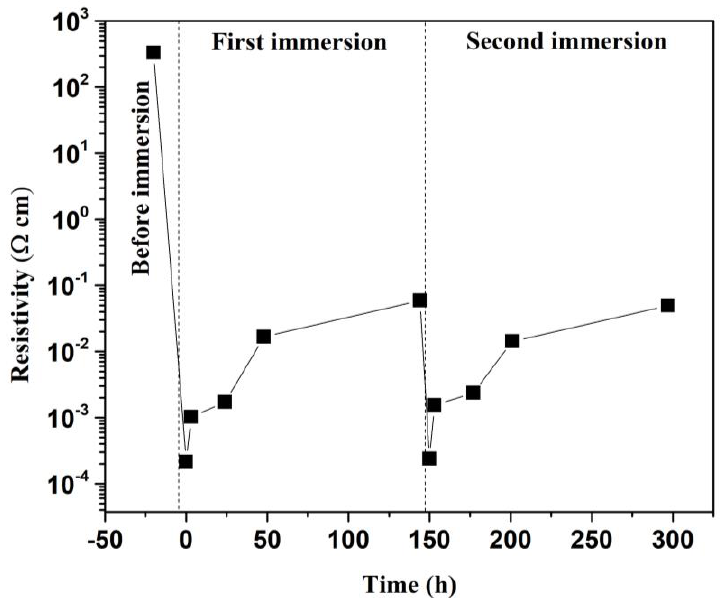
Figure 5. The resistivity behavior of sensitized P3HT thin films, over time.